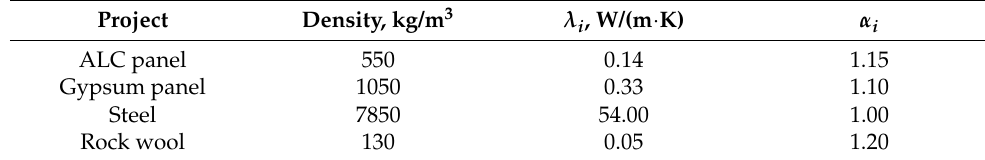
Table 2. Material parameters of each structural layer.